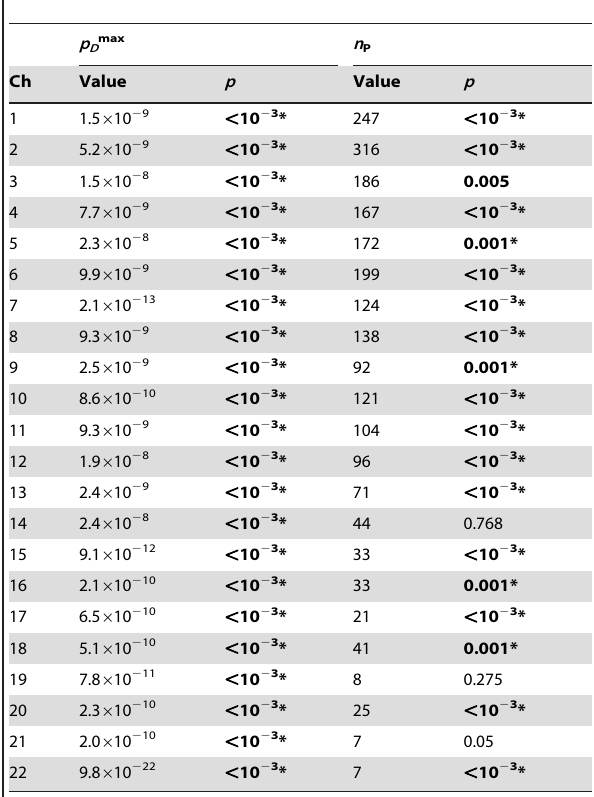
Table 1. Results for the test statistics p D max and n P .